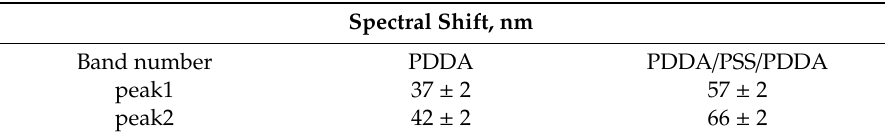
Table 4. Spectral shift of local transmission bands for two layers of 300-nm silica particles over PDDA or PDDA / PSS / PDDA intermediate